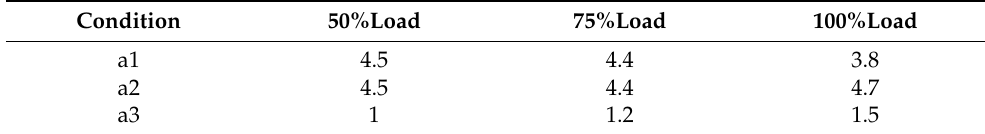
Table 4. Weight of